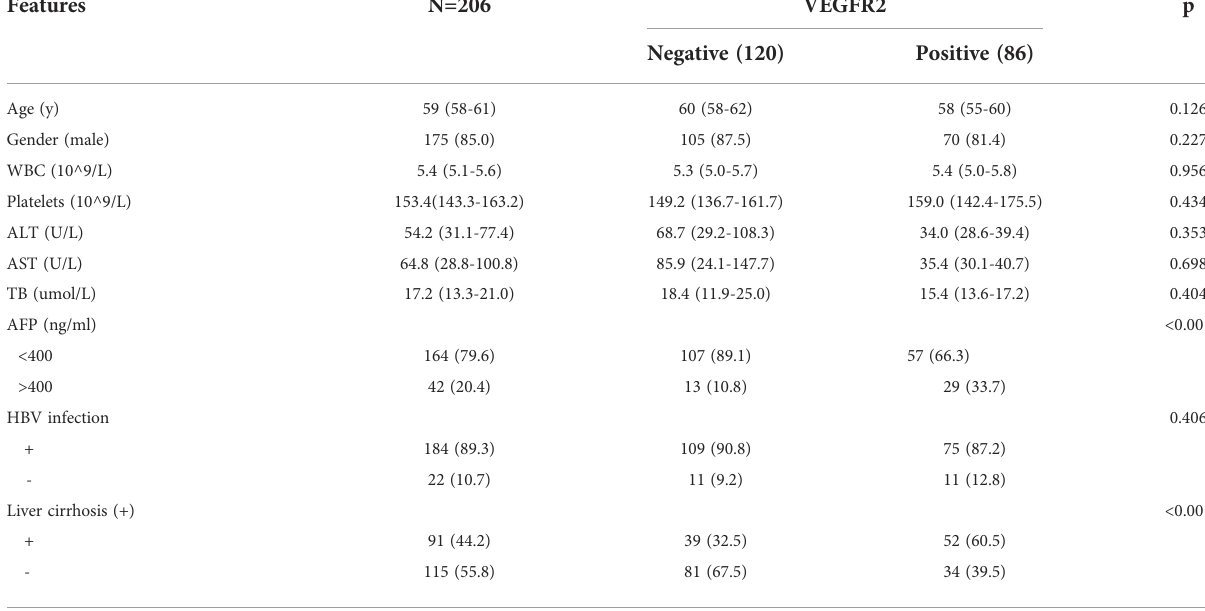
TABLE 1 Characteristics of the 206 patients strati fi ed by the VEGFR2 status of HCC.